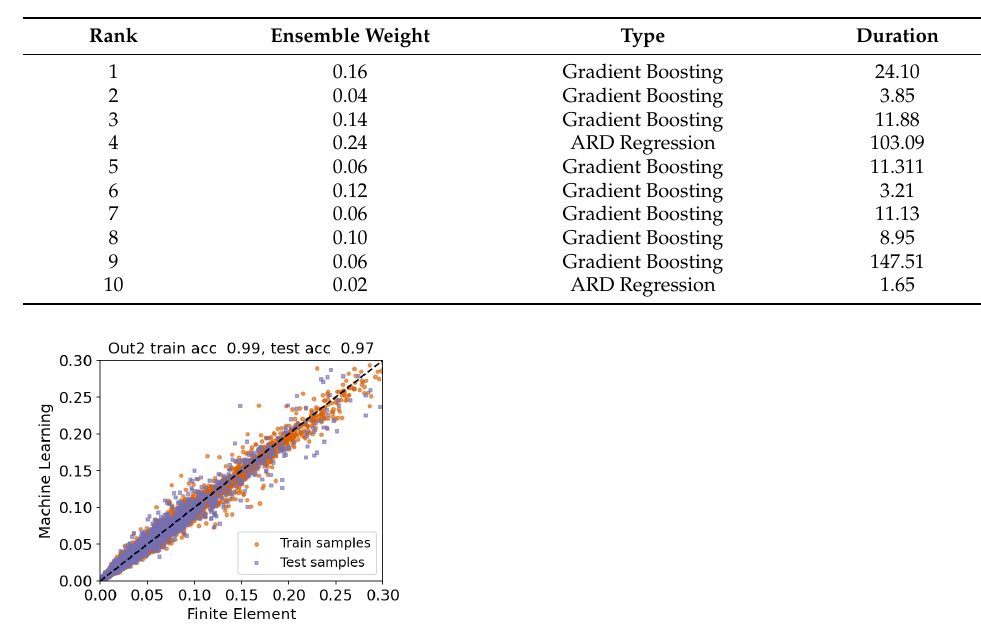
Table 2. The result of model selection performed by auto-sklearn when considering a single output (Scenario 1).